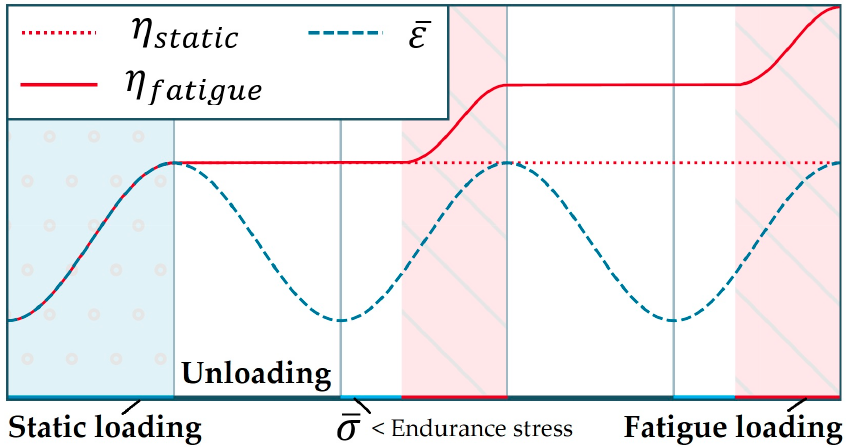
Figure 4. Evolution of history variable 𝜂 over the state of strain cycles 𝜀̅